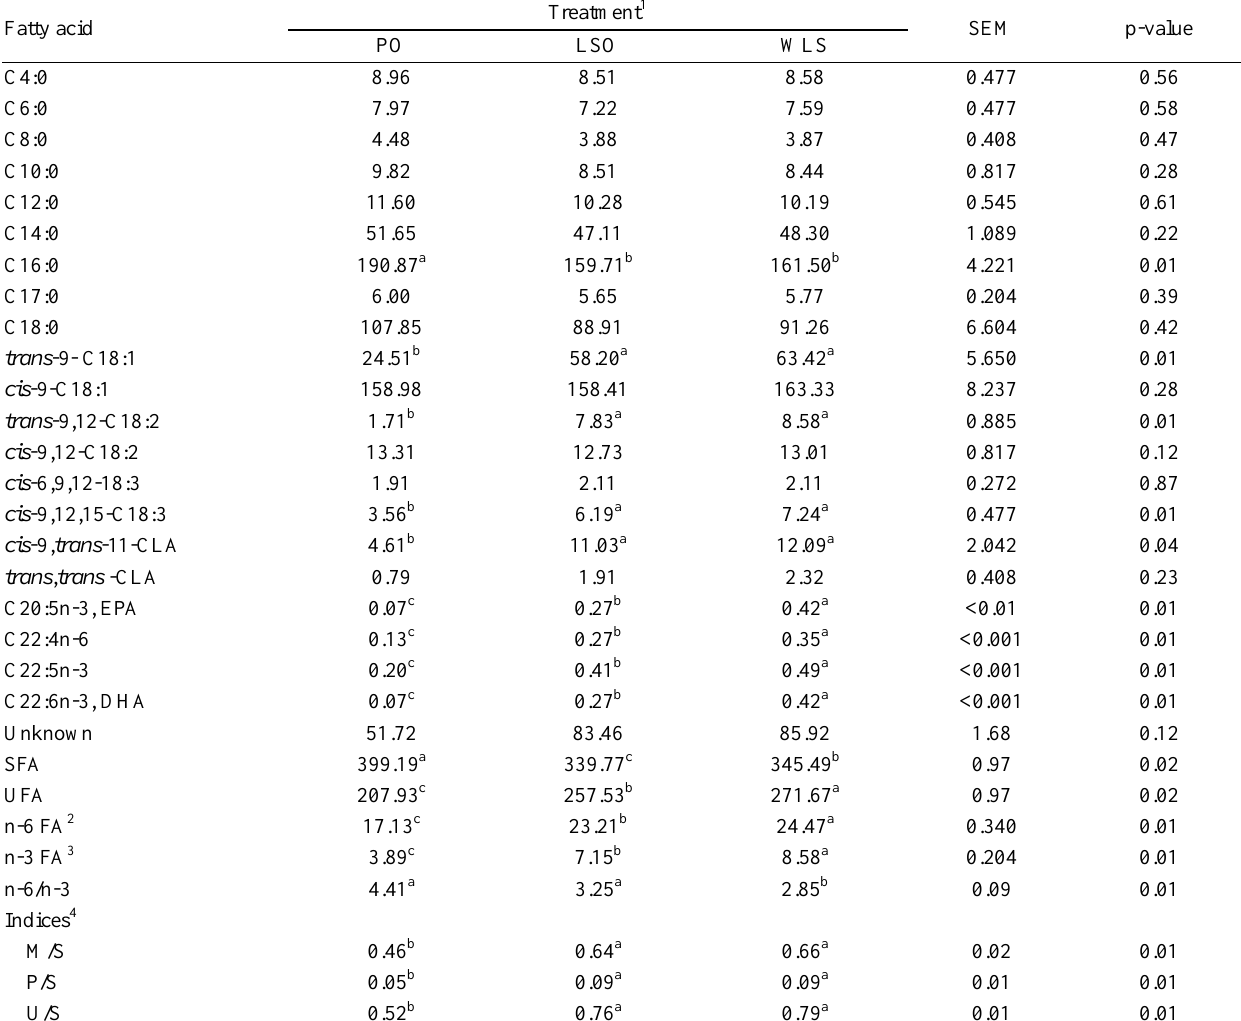
Table 6. Milk fatty acid yield (g/d) of cows fed linseed oil or whole linseed Fatty acid